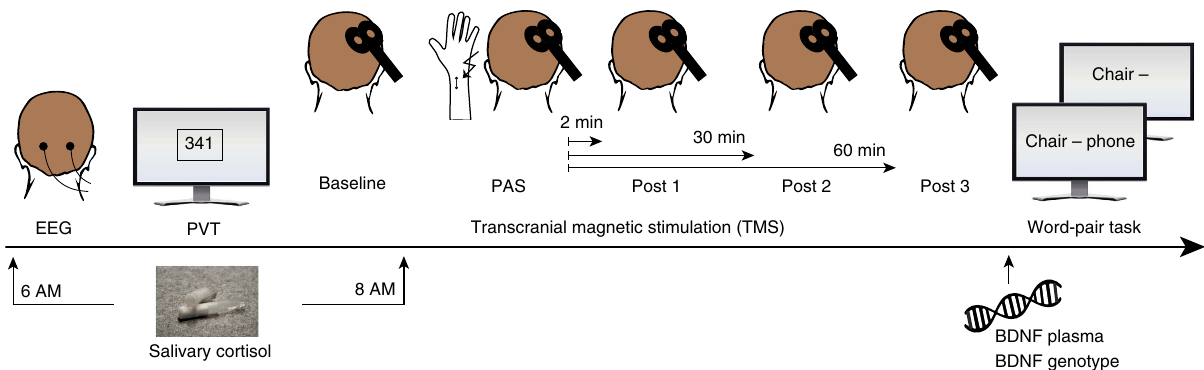
Figure 6 | Electrophysiological, behavioural and molecular assessments. Measurements started at 6:45 AM with the wake electroencephalography (EEG) and Psychomotor Vigilance Task (PVT). At 0800h, the TMS protocol was started consisting of a baseline measurement followed by paired associative stimulation (PAS) and three post measurements (2, 30 and 60min after the end of PAS). Salivary cortisol was assessed at 0600h and 0800h. After the TMS measurement, 15ml of blood was taken to determine brain-derived neurotrophic factor (BDNF) plasma concentration and BDNF genotype. Last, a declarative memory task (word-pair task) was